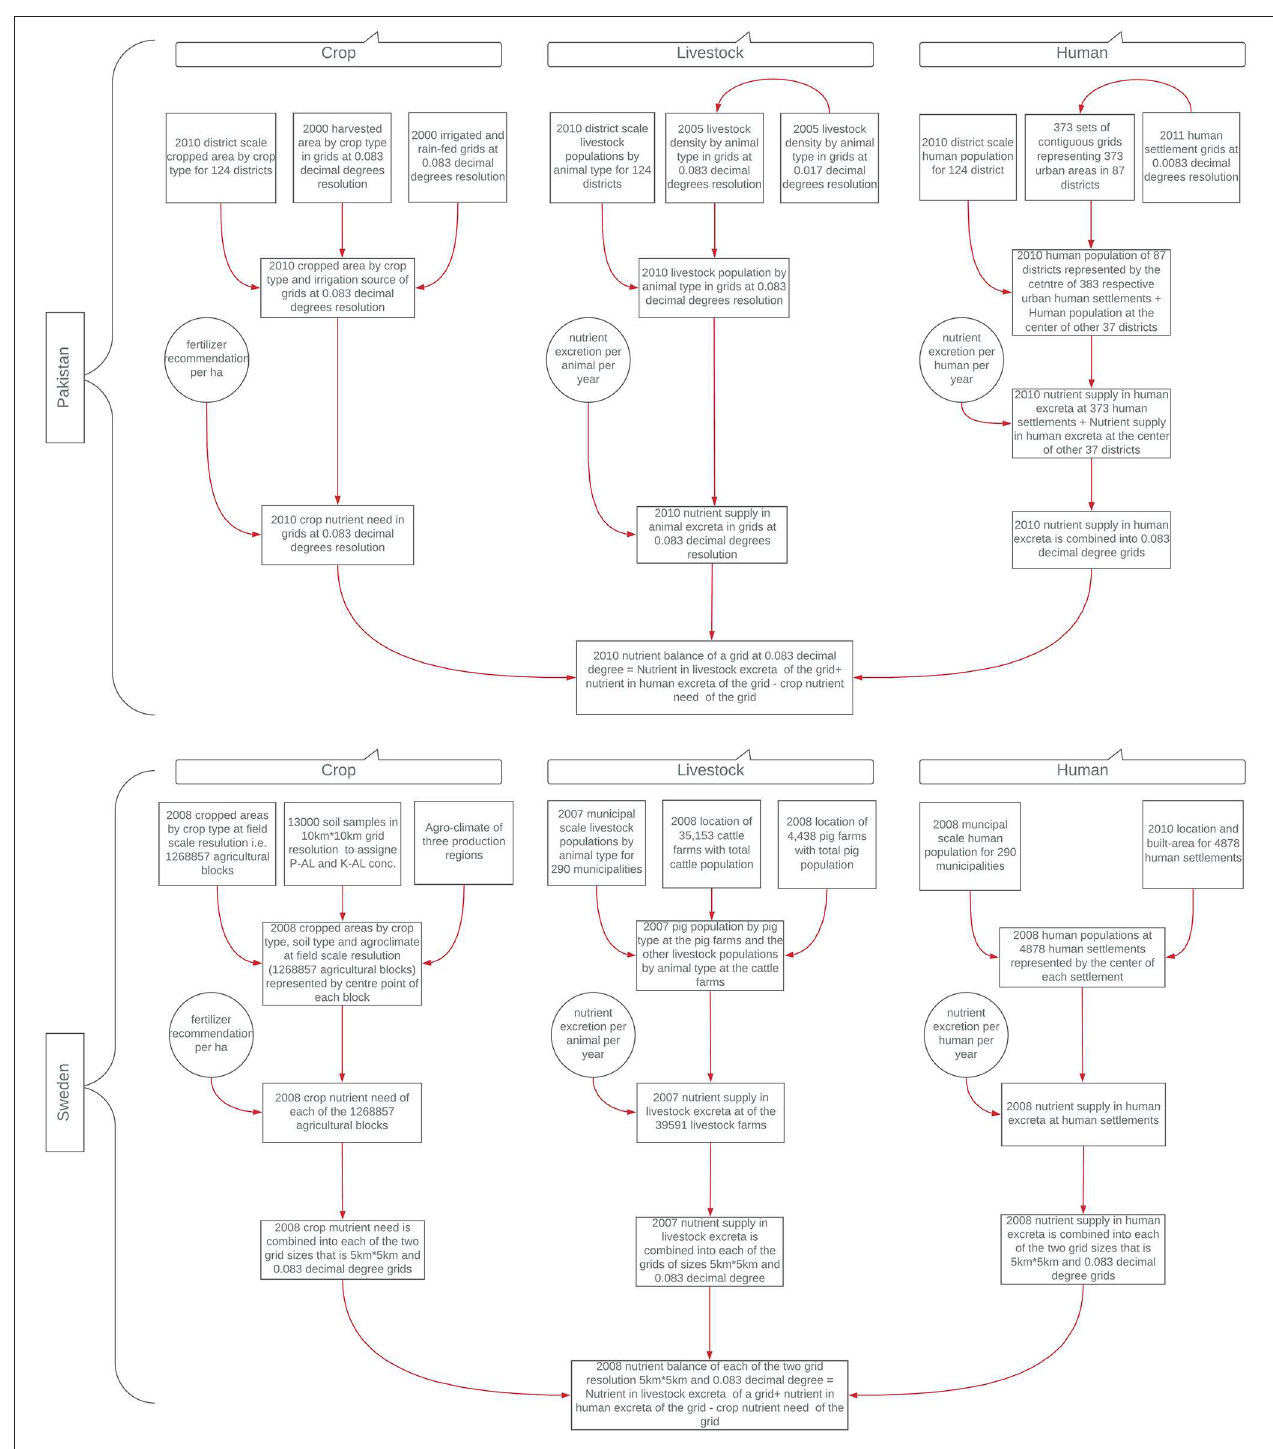
FIGURE 1 | Data transformations from lower to higher resolution used to calculate nutrient balances in grids in Sweden and Pakistan. In Pakistan, the political scale (district) data for crops, livestock, and humans were converted to 0.083 decimal degree grids. In Sweden, the higher resolution crop data were transformed to include information of soil type and production region, and political scale (municipal) data for livestock and human were converted to farm livestock type and numbers, and human population to human settlement locations. All these datasets were then converted into crop nutrient needs and excreta nutrient supply and then into the gridded nutrient balances in each